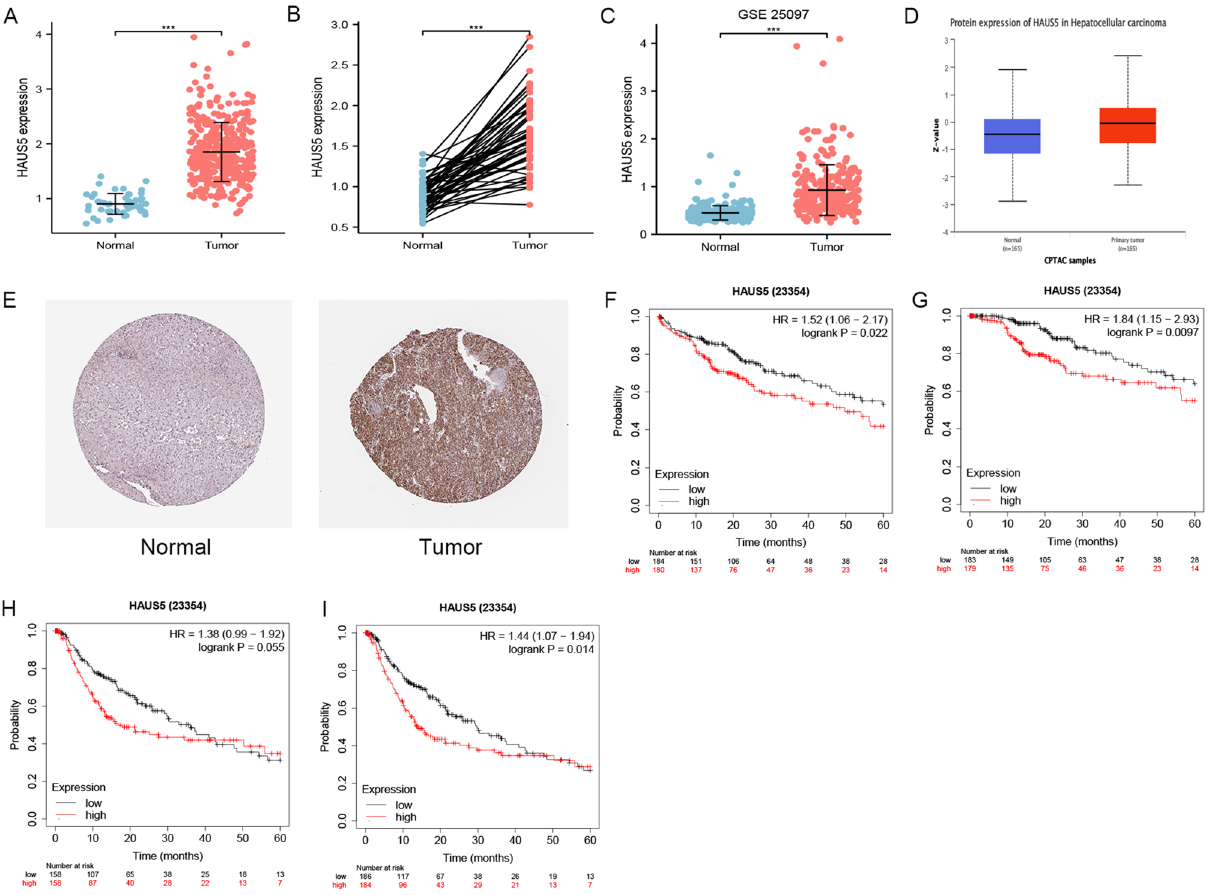
Figure 3. High expression and prognostic value of HAUS5 in LIHC. HAUS5 was overexpressed in ( A ) TCGA- LIHC samples, ( B ) TCGA-LIHC paired samples and ( C ) the GSE25097 dataset. ( D ) The protein expression levels of HAUS5 based on CPTAC. ( E ) The protein levels of HAUS5 analyzed by the Human Protein Atlas. HAUS5 expression was associated with prognosis according to the Kaplan ‒ Meier Plotter database: ( F ) OS, ( G ) DSS, ( H ) RFS and ( I ) PFS. * P < 0.05, ** P < 0.01, *** P <